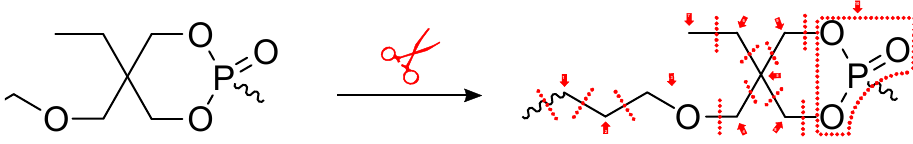
Figure 13. Structure fragmentation of dioxaphosphorinane group into smaller groups.